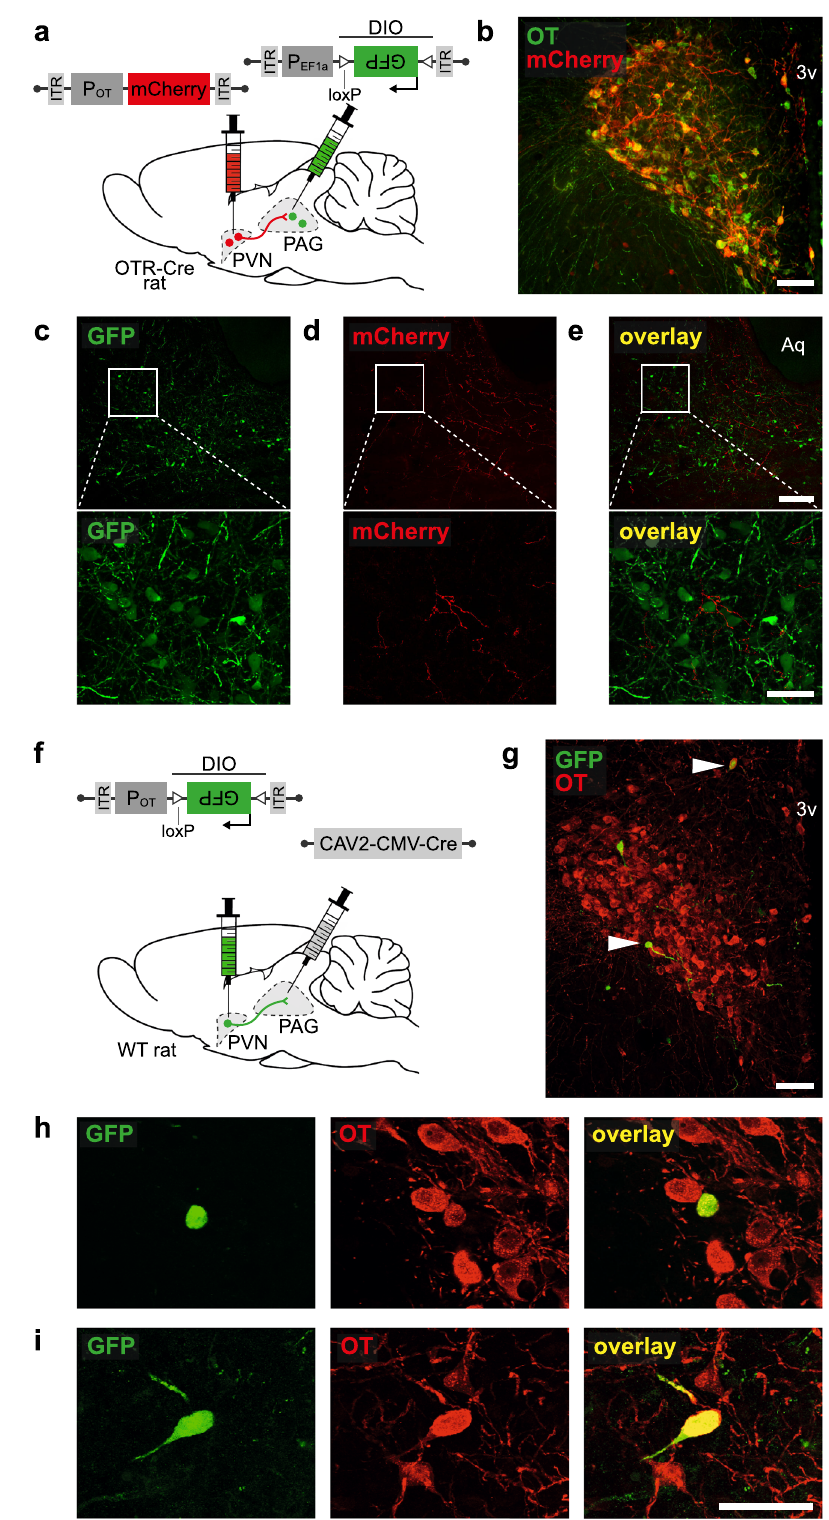
Fig. 2 | PVN ParvOT neurons send axonal projections to vlPAG of female rats. a – e Anterograde tracing of projections from PVN OT-neurons to the vlPAG. a Schema of viral injection showing injection of rAAV 1/ 2 -pOT-mCherry in the PVN and rAAV 1/ 2 -pEF1 α -DIO-GFP in the PAG of OTR-Cre rats ( n =4 female rats). b Image showing co-localization of rAAV 1/ 2 -pOT-mCherry and OT in the PVN. Scale bar = 200 µ m. 3v = third ventricle. c – e Images of GFP (green, c ) and mCherry (red, d ) staining in the vlPAG showing PVN OT fi bers surrounding vlPAG GFP neurons ( e ). Scalebar=300 µ m,zoomscalebar=40 µ m.Aq=Aqueduct. f – i Retrogradetracing